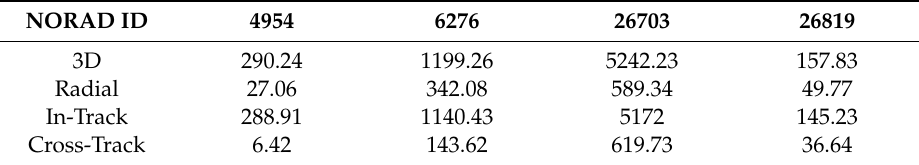
Table 8. The 3D position di ff erence (m) RMS of 1-day arc angle data from two sites.